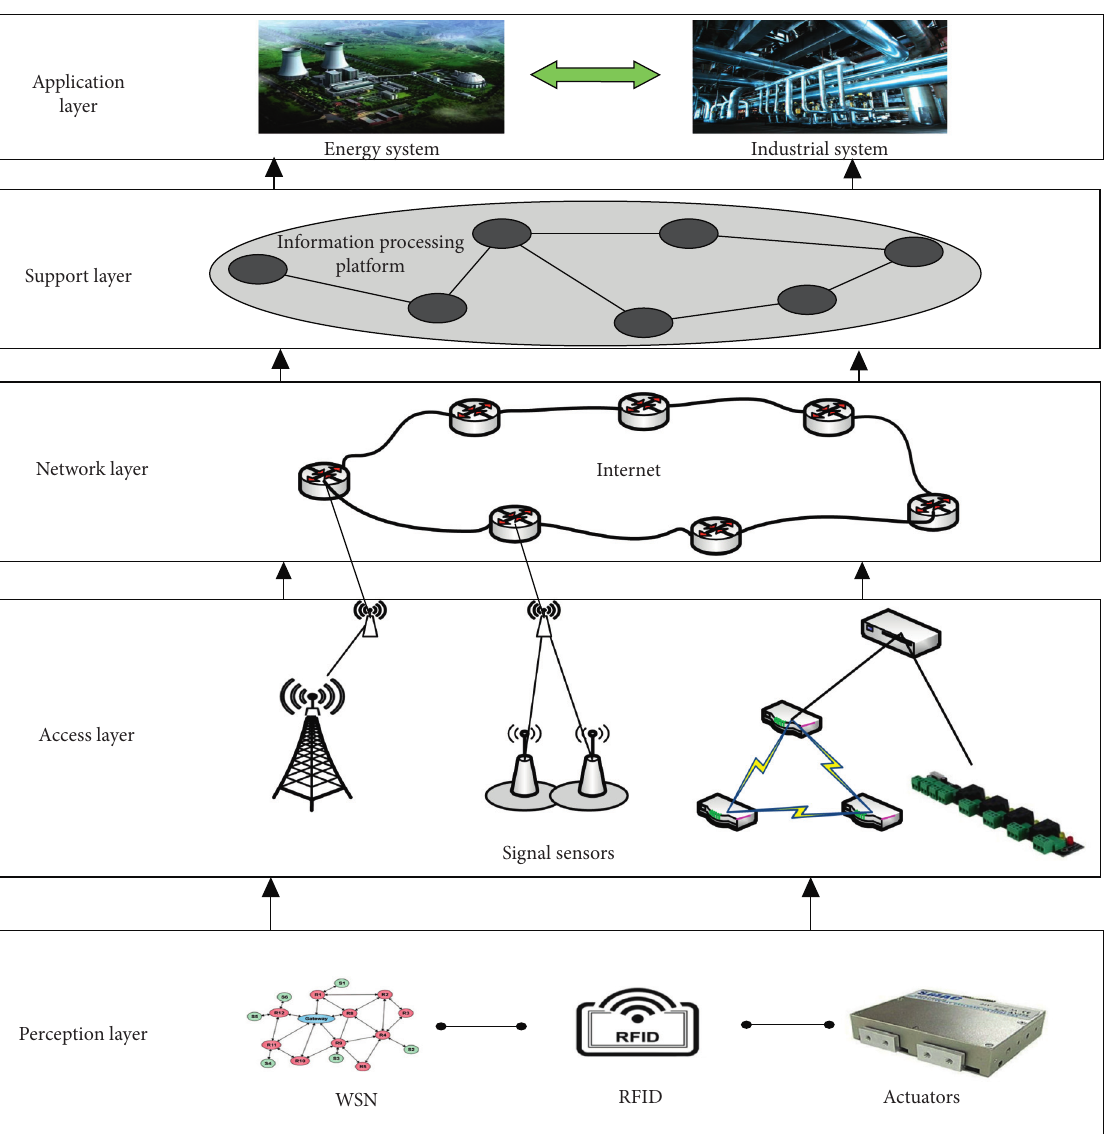
Figure 1: Multilayer architecture of